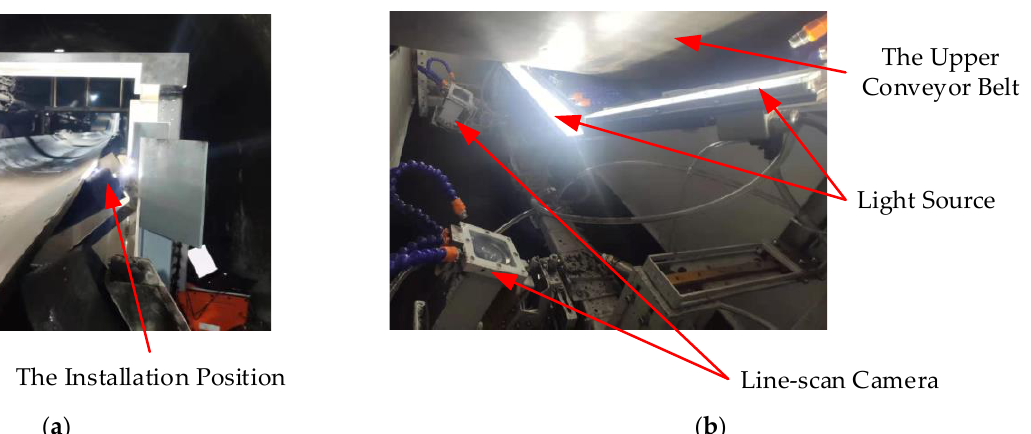
Figure 15. Application of the proposed research. ( a ) A mine site. ( b ) The installed device.